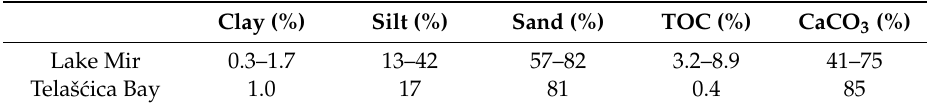
Table A1. The grain size distribution data, total organic carbon (TOC), and carbonate content (CaCO 3 ) content of the Lake Mir and the Telaš´cica Bay sediments, previously reported by Mlakar et al.